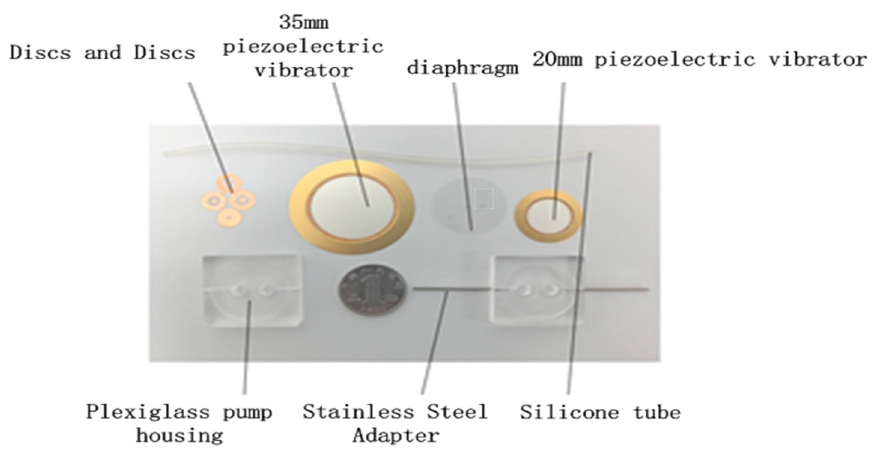
Figure 4. The layout of the prototype.